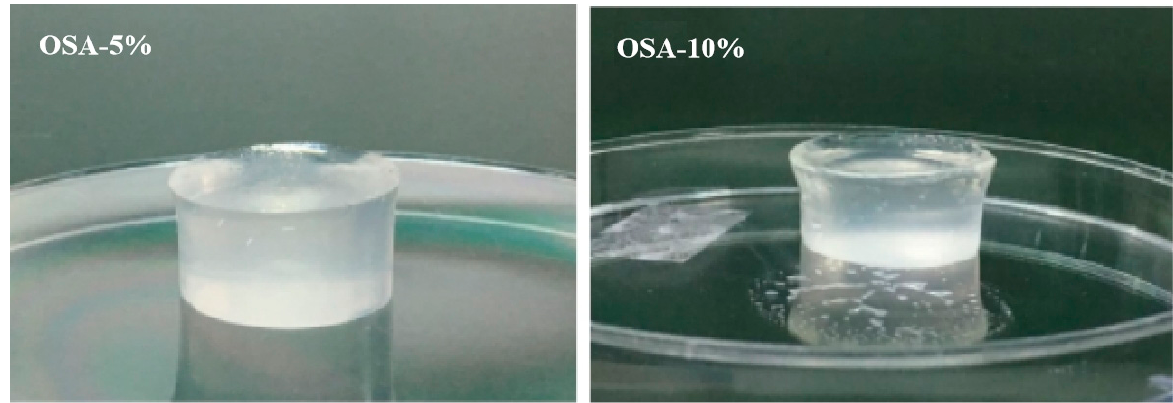
Figure 10. The physical picture of OSA—5% and OSA—10% hydrogel.